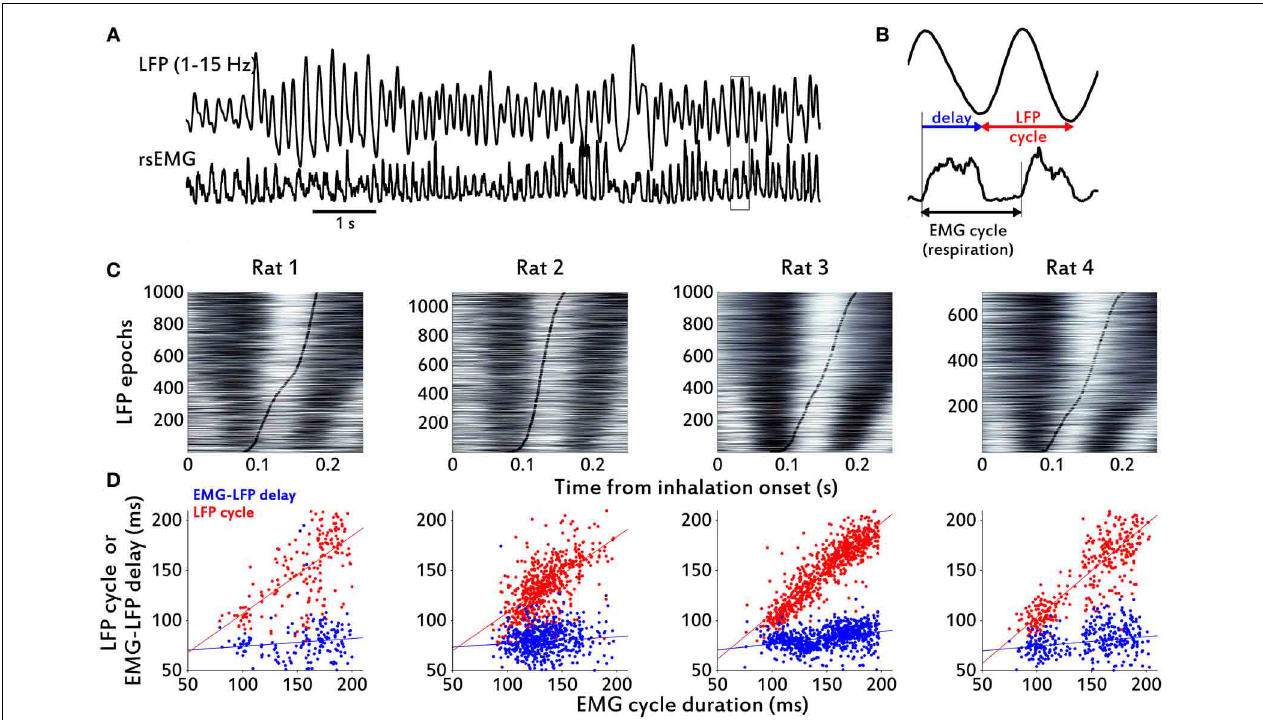
FIGURE 4 | Cycle-by-cycle agreement between diaphragmatic respiration and OB LFP. (A) Filtered LFP (1–15Hz) and rsEMG example traces from Rat 1. (B) Enlarged plot from section marked with a rectangle in (A) , to show the delay between EMG cycle onset and LFP cycle onset, and the LFP cycle. (C) Raster plots of peri-inhalation LFP epochs, sorted by respiration cycle duration (shortest at bottom; white represents values above zero). Black thick lines mark the end of the respiratory cycle estimated from the EMG for each epoch. Note that the end of the EMG cycle precedes the end of the LFP